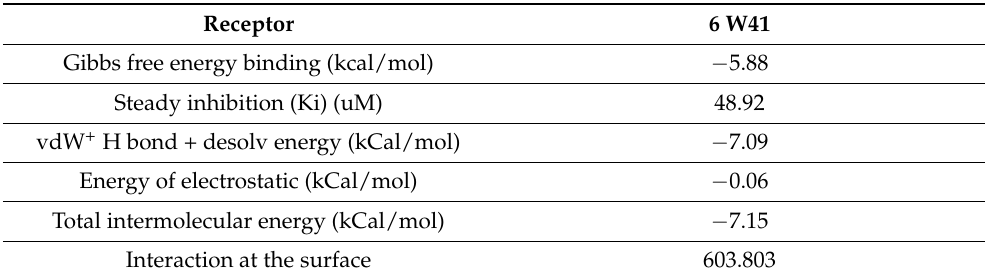
Table 2. The energy-derived values in the ligand (HL) docking calculations were calculated using unliganded active site primary protease COVID-19